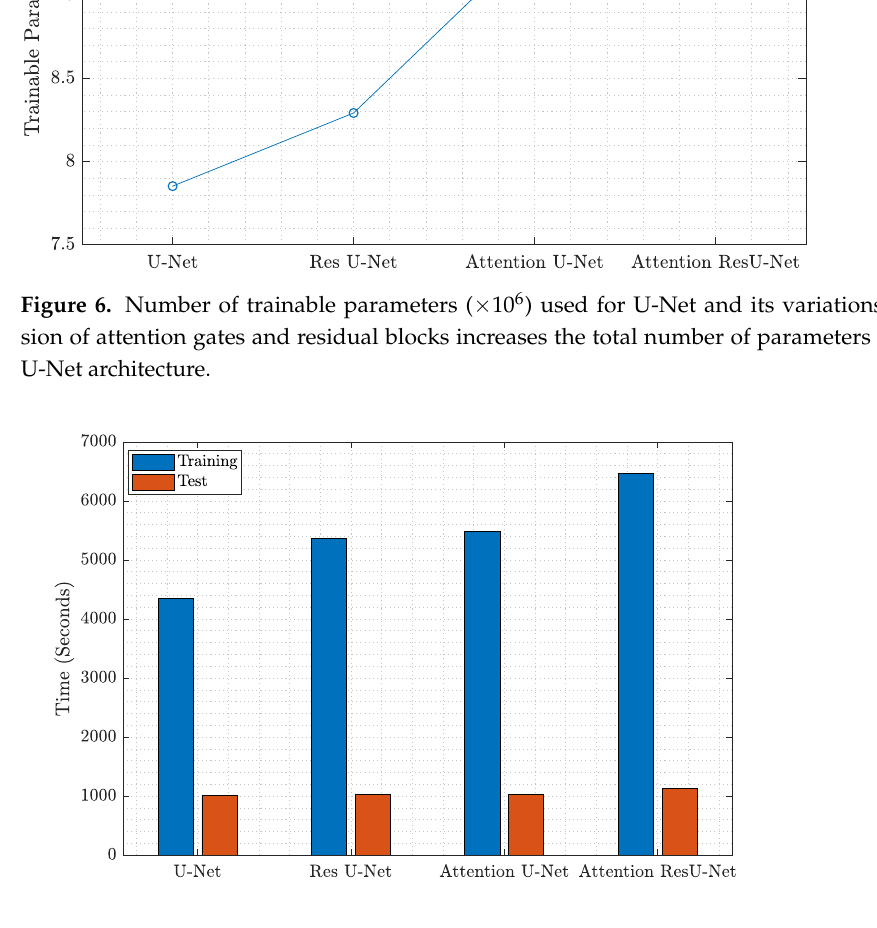
Figure 7. Total training and testing times in seconds for the U-Net architecture and its variations. The increase in the models’ complexity due to the inclusion of attention gates and residual blocks has an impact on the training